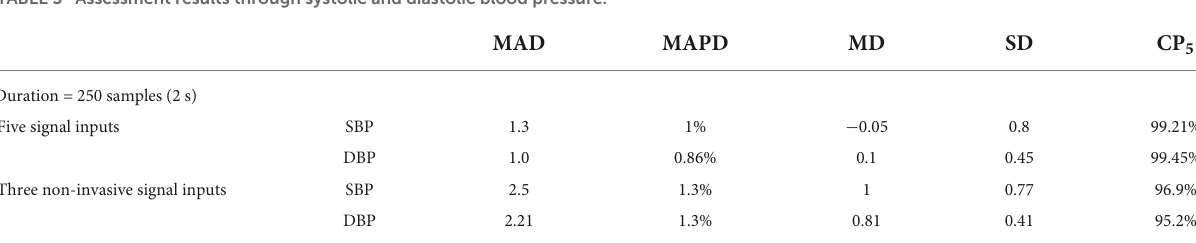
TABLE 3 Assessment results through systolic and diastolic blood